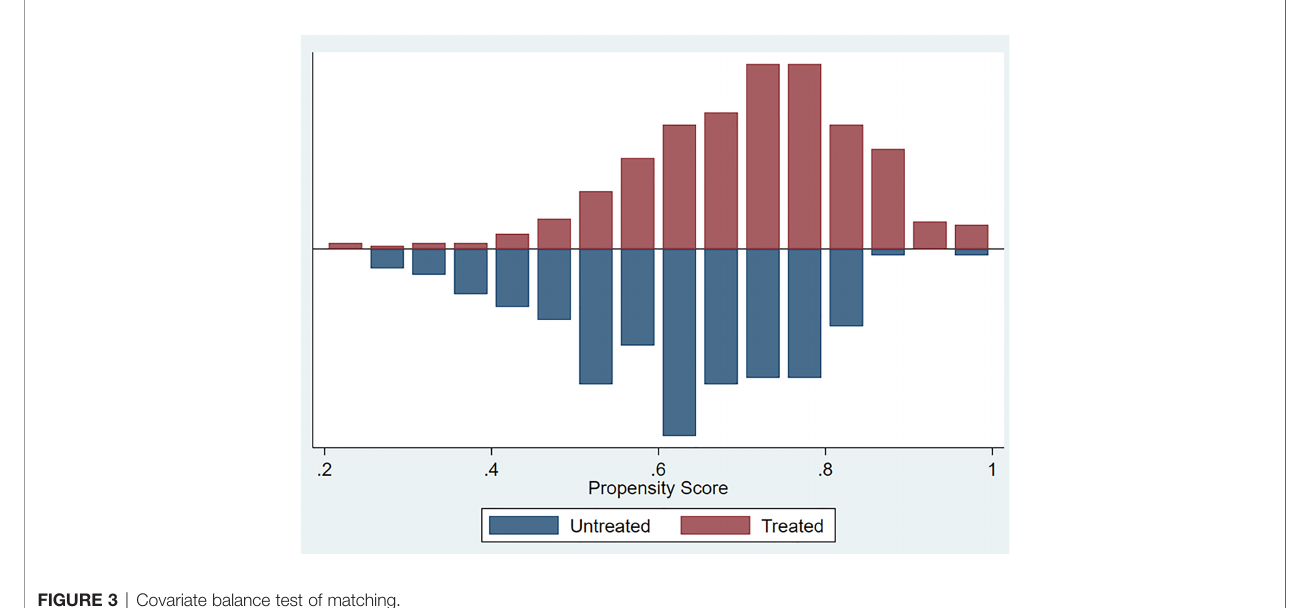
FIGURE 3 | Covariate balance test of